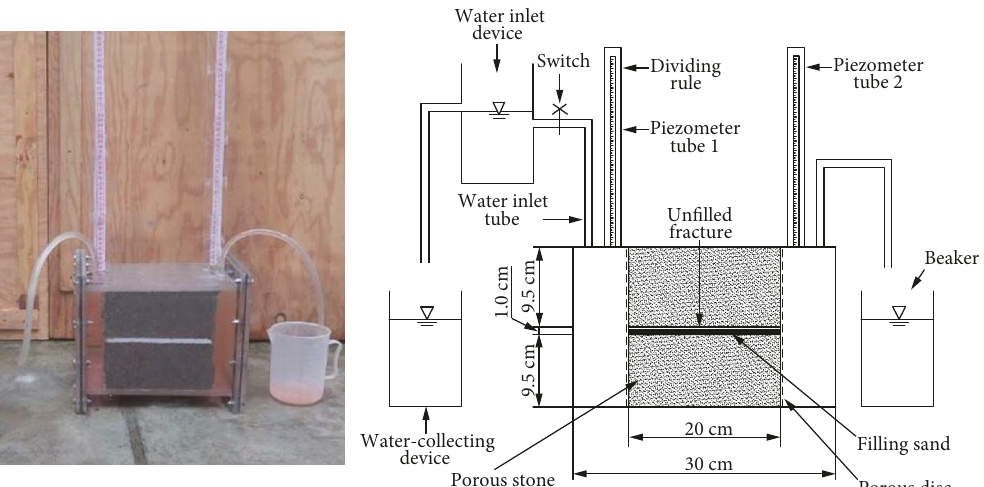
Figure 3: Seepage testing equipment for the fractured rock